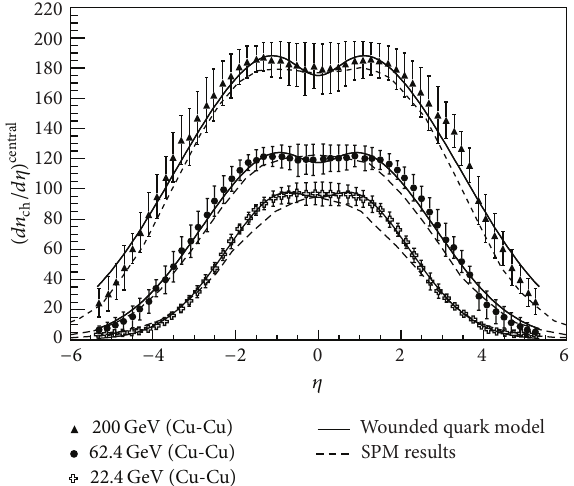
Figure 8: Charged hadron pseudorapidity distribution in Cu-Cu collisions at different RHIC energies along with comparison of different model results. Data are taken from [129].